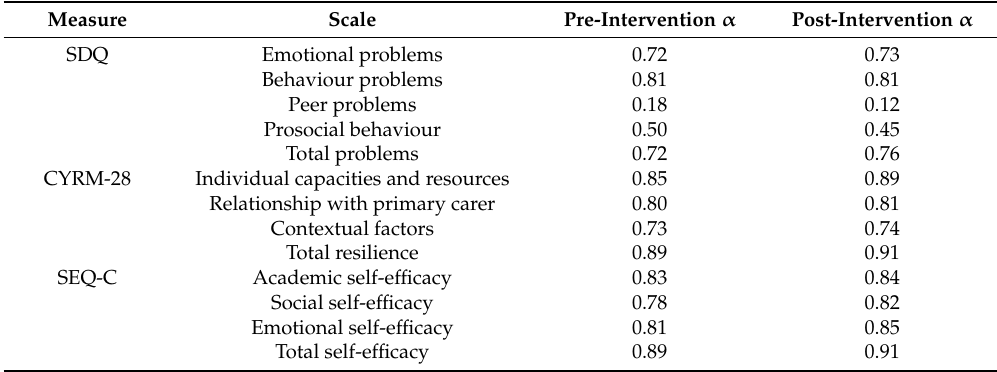
Table 3. Internal consistency for SDQ, CYRM-28 and SEQ-C across pre-intervention and post-intervention